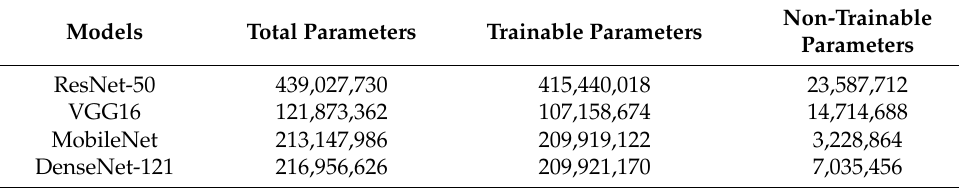
Table 3. Parameters of the pre-trained models in this